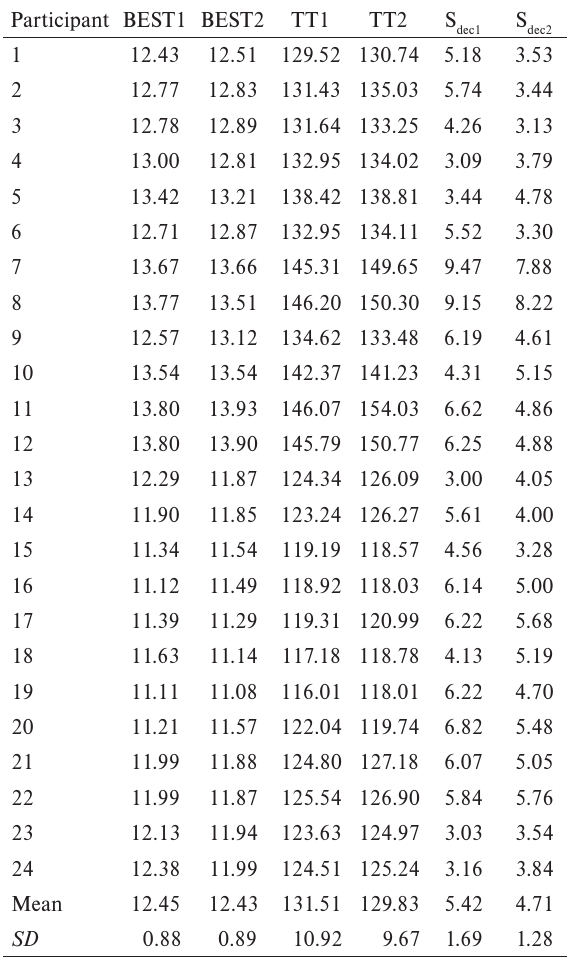
Individual times of participants during all measurements Participant BEST1